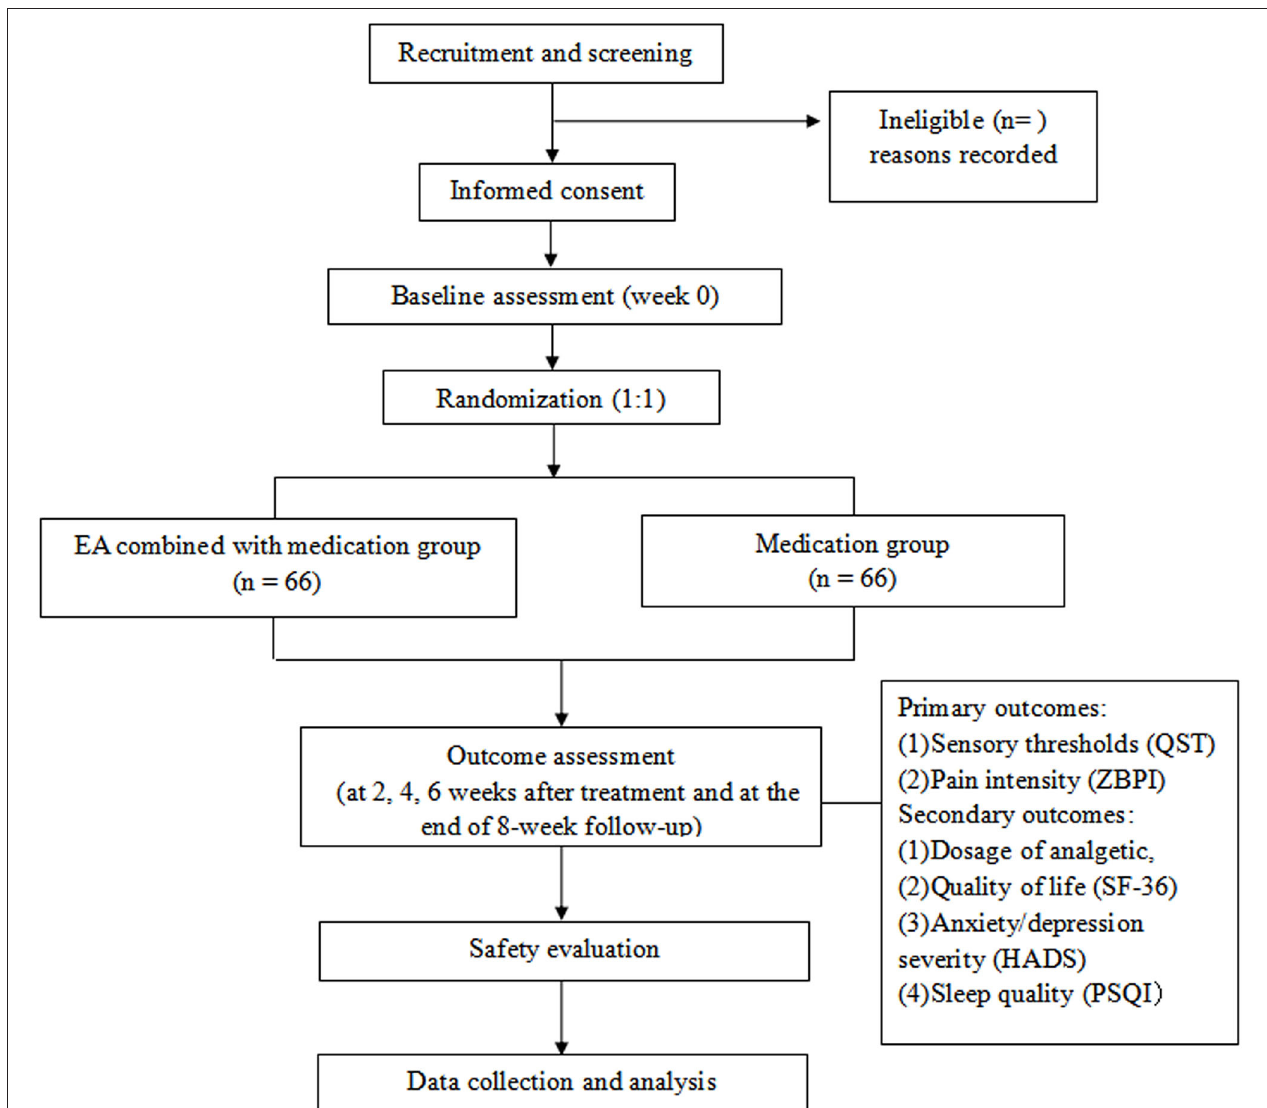
FIGURE 1 | Flow chart of the study process. EA, electroacupuncture; HADS, Hospital Anxiety and Depression Scale; PSQI, Pittsburgh Sleep Quality Index; QST, Quantitative Sensory Testing; SF-36, Short Form 36 Health Survey; ZBPI, Zoster Brief Pain Inventory.